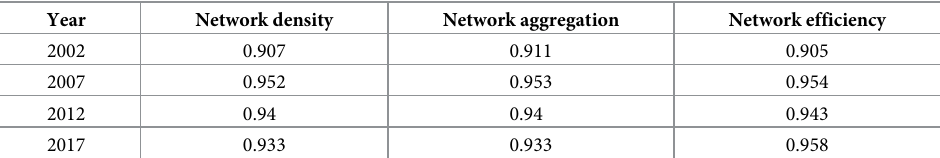
Table 1. Evaluation results of industry network.